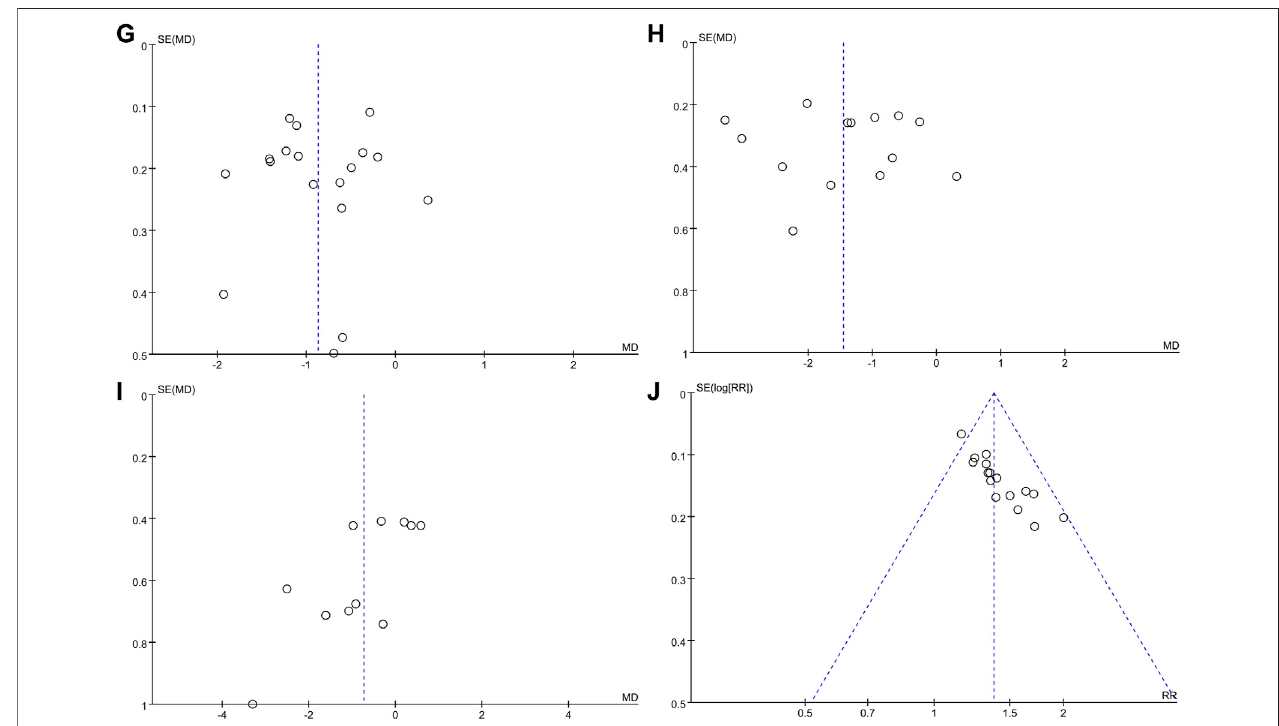
FIGURE 8 | Funnel plots for assessing publication bias. (A) TG; (B) TC; (C) LDL-C; (D) HDL-C; (E) ALT; (F) AST; (G) FBG; (H) 2hPG; (I) BMI; and (J) overall effective